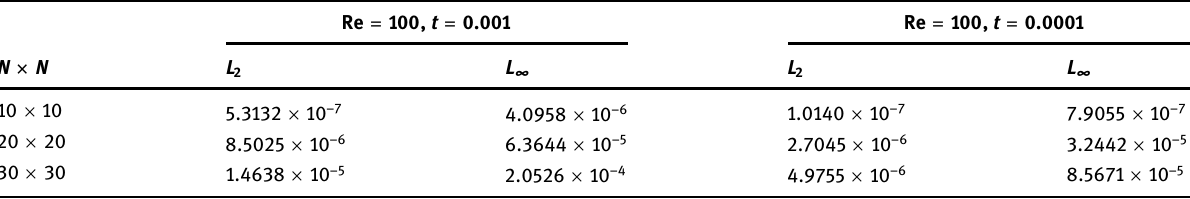
Table 10: Error norms